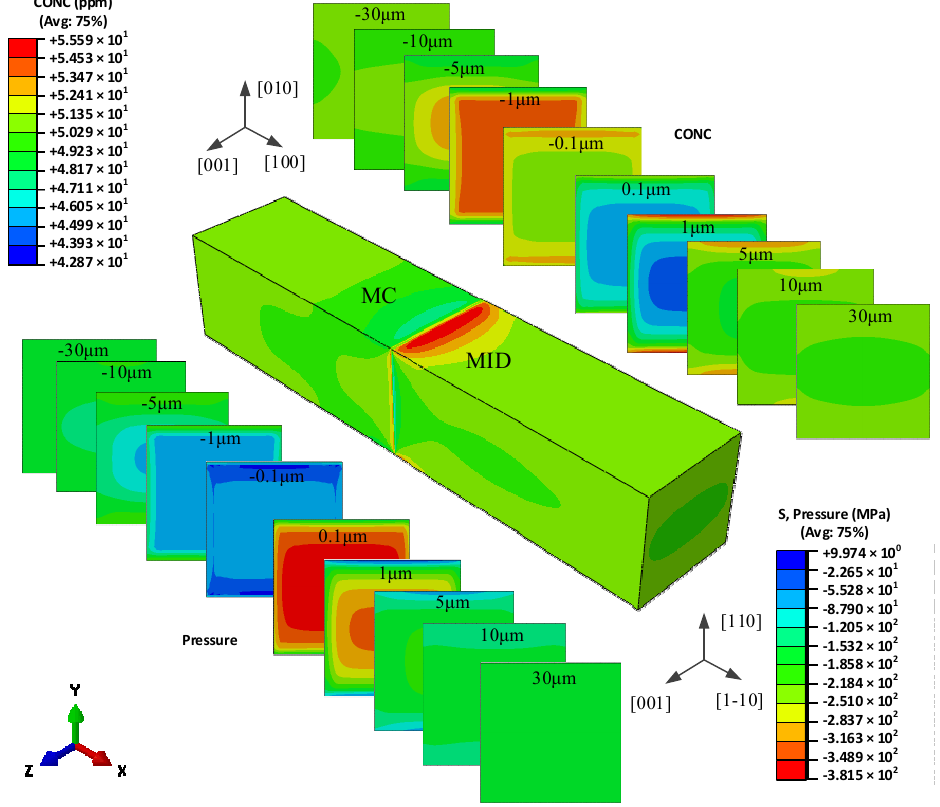
Figure 4. The hydrogen concentration distribution in the model I bicrystal.